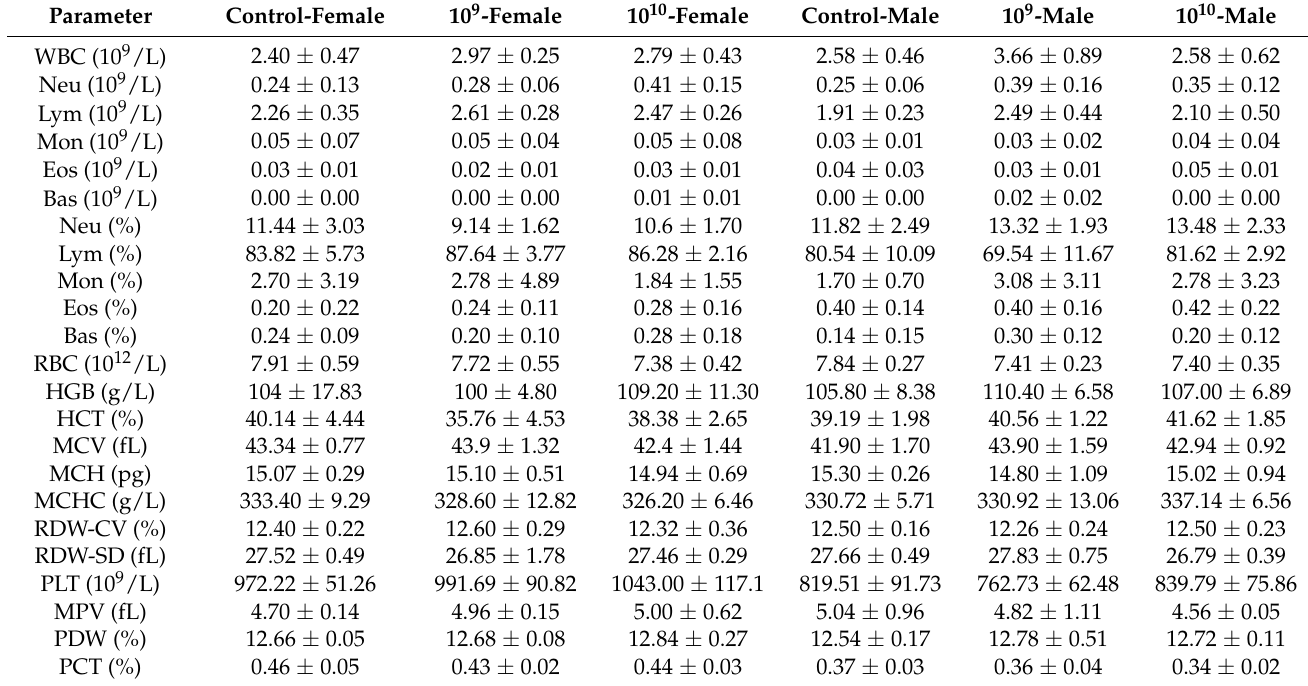
Table 4. Effect of Blautia producta DSM 2950 on hematological parameters.